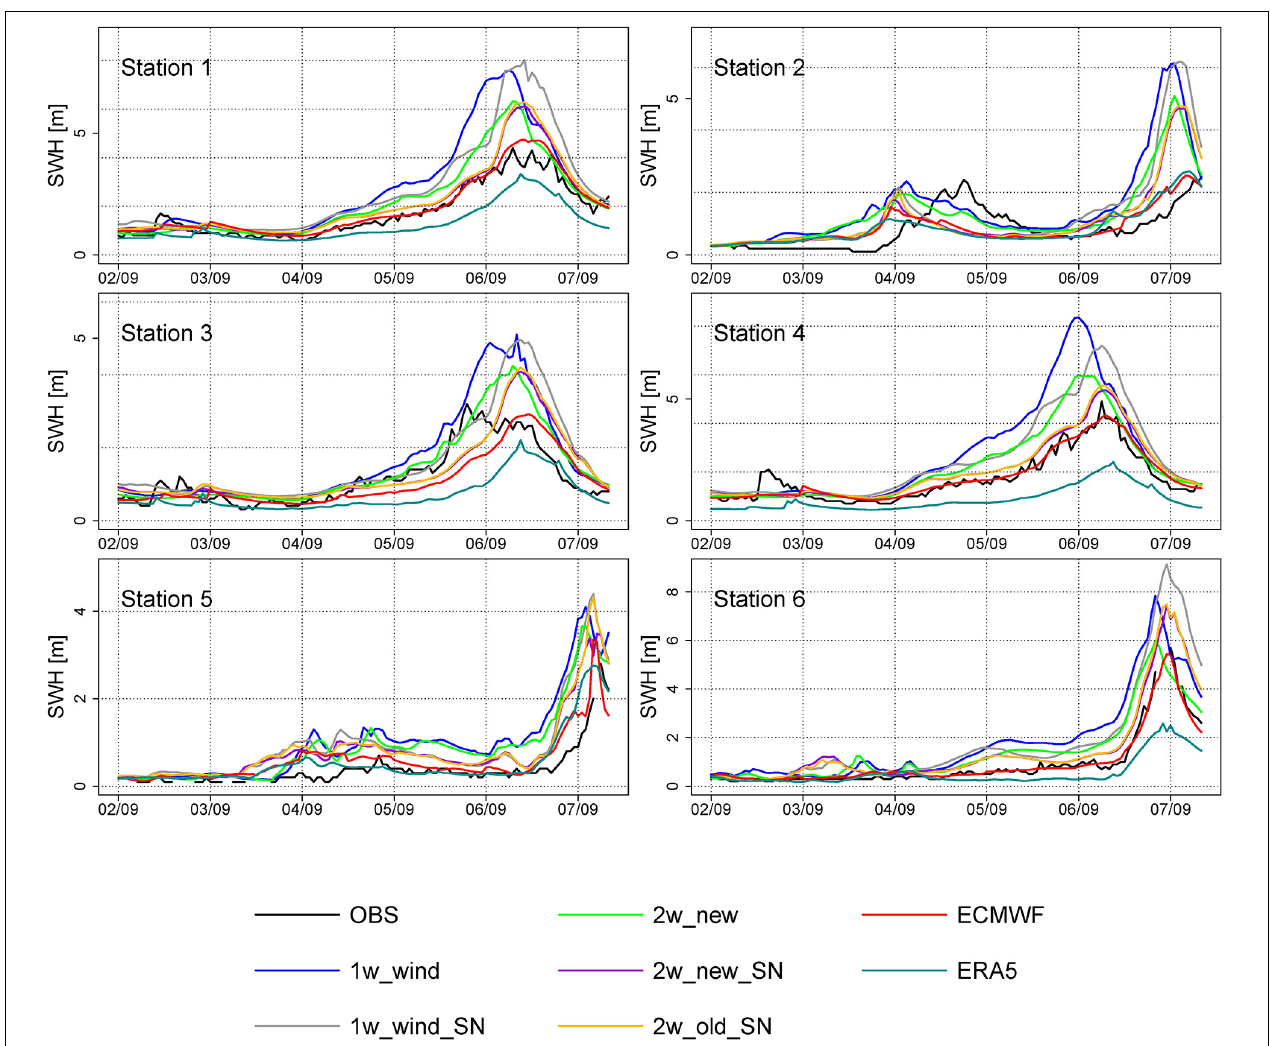
FIGURE 9 | The same as Figure 8 , but for significant wave